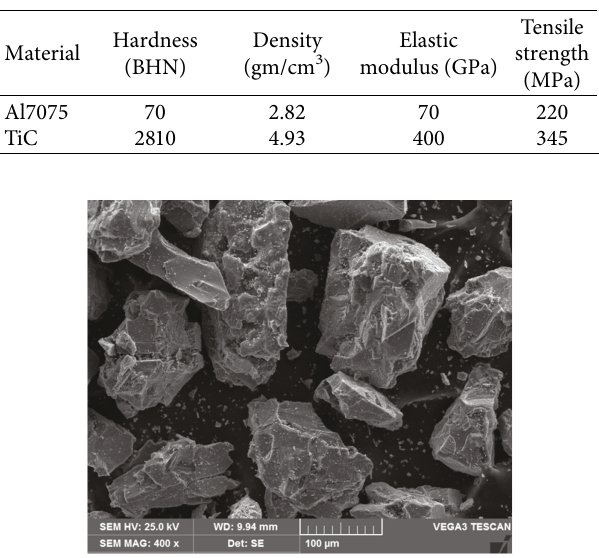
Table 2: Properties of Al7075 alloy and TiC particles.